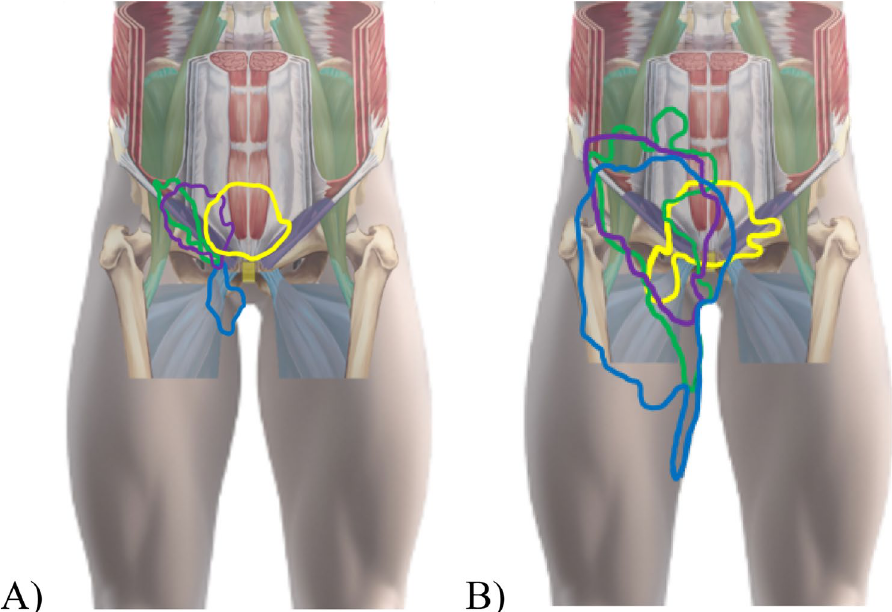
Figure 4. Distributions of pain incorporating the Doha agreement illustration of the four defined clinical entities, using the outlines from adductor-related (blue), inguinal-related (purple), iliopsoas-related (green), and pubic-related (yellow) groin pain from the pain drawing overlay images. All data are flipped to the right side to show common locations. ( A ) Illustrates the area where the majority (≈75%) of athletes reported their pain, whereas ( B ) illustrates the area where a minimum of two athletes reported their pain.